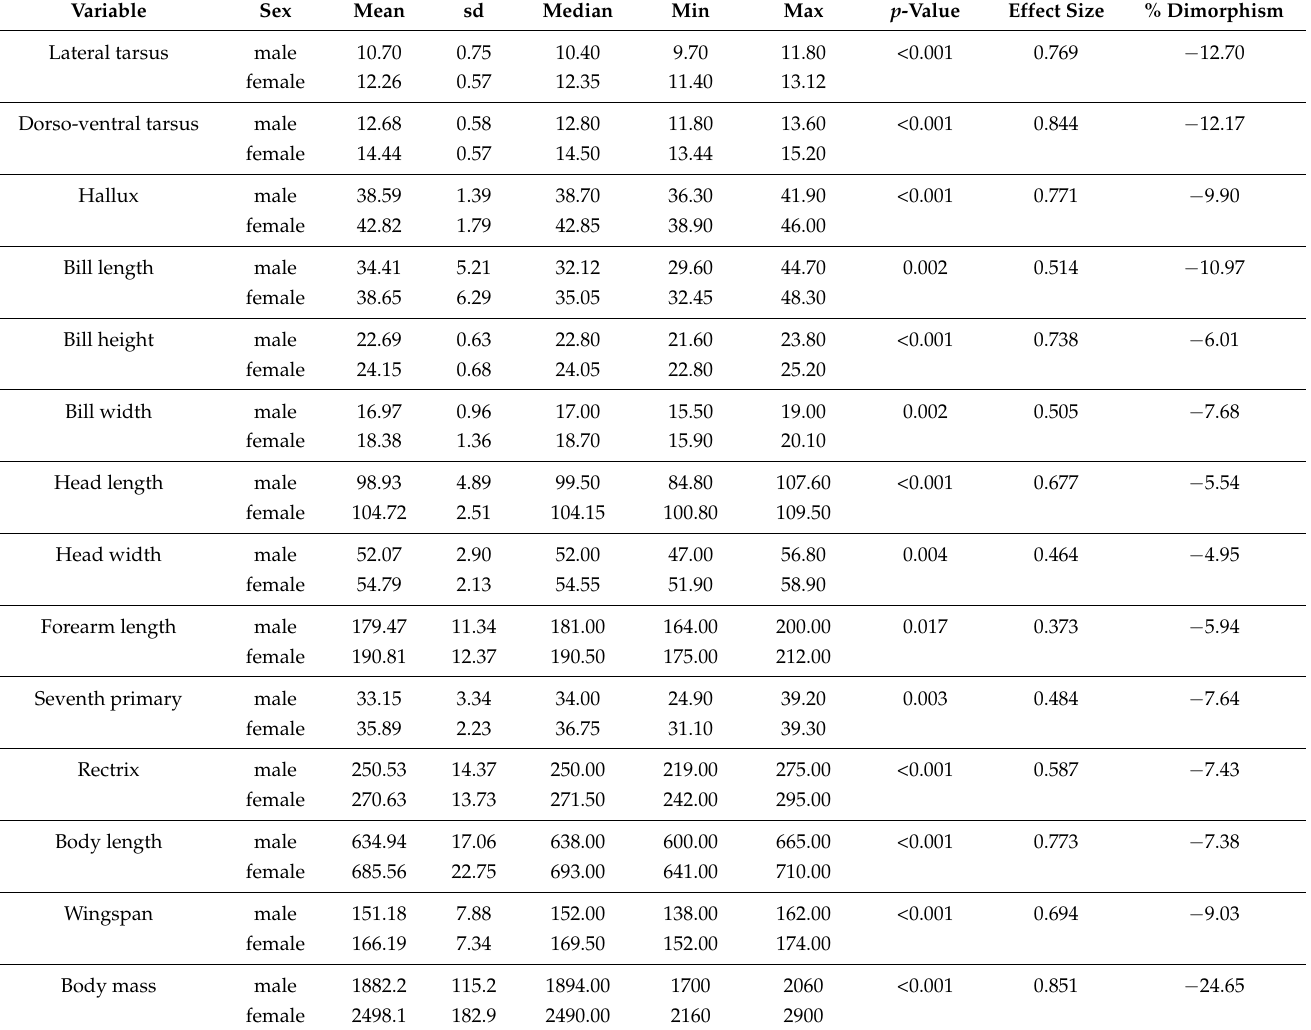
Table 3. Summary statistics and results of the Mann–Whitney test of morphometric measurements of adult male ( n = 17) and female ( n = 16) Bonelli’s eagles from eastern Spain sexed by molecular techniques. Values are given in mm except body mass which is given in grams. The importance of each variable in the identification of the sexes with respect to the other variables (effect size) and the percentage of sexual dimorphism are